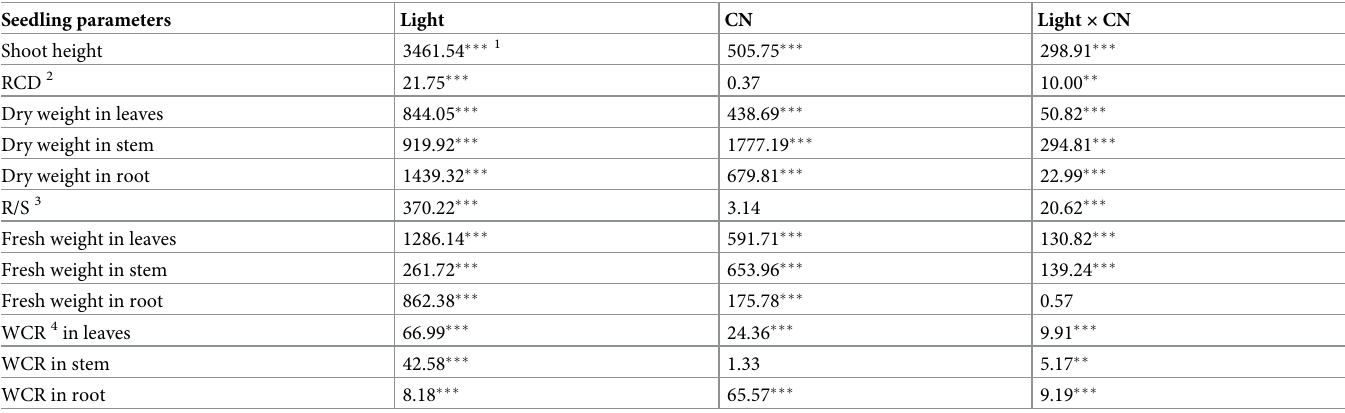
Table 2. F values from analysis of variance (ANOVA) of effects of light quality (Light), chitosan nanoparticle addition (CN), and their interaction (Light × CN) on aerial growth and whole-plant dry weight, fresh weight, and water content ratio in Eleutherococcus senticosus seedlings. Seedling